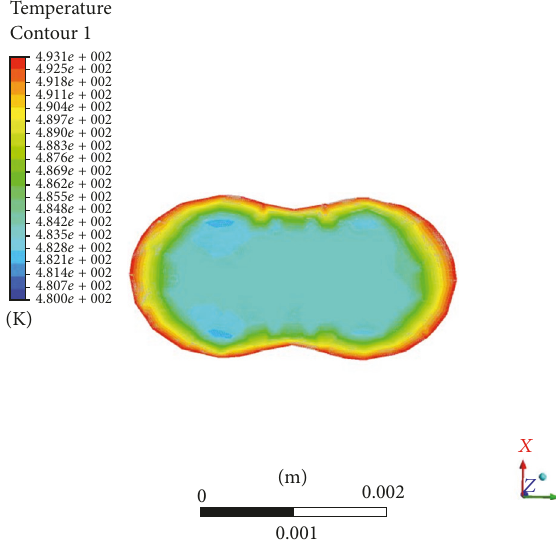
Figure 7: Temperature contours of the intersection cross section in the steady state at the temperature of 493.15 K.